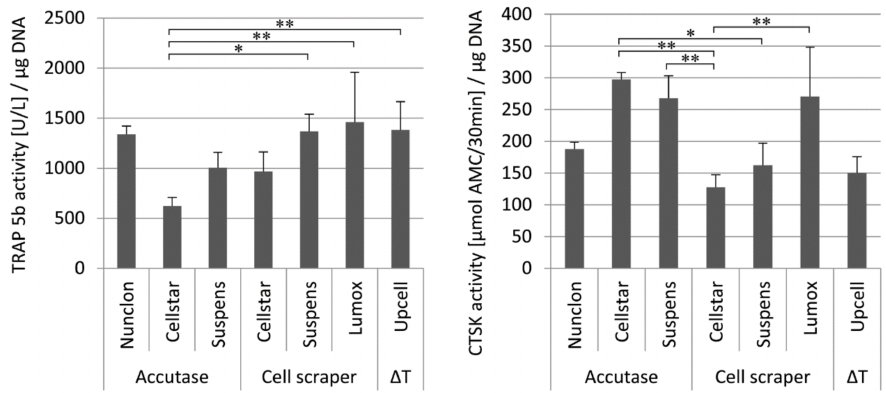
Figure 5. Intracellular TRAP 5b activity ( left ) and intracellular CTSK activity ( right ) of reseeded mature osteoclasts depending on the different detachment methods after 7 days of cultivation on Nunclon TM reference plates, * indicate p < 0.05, ** indicate p <